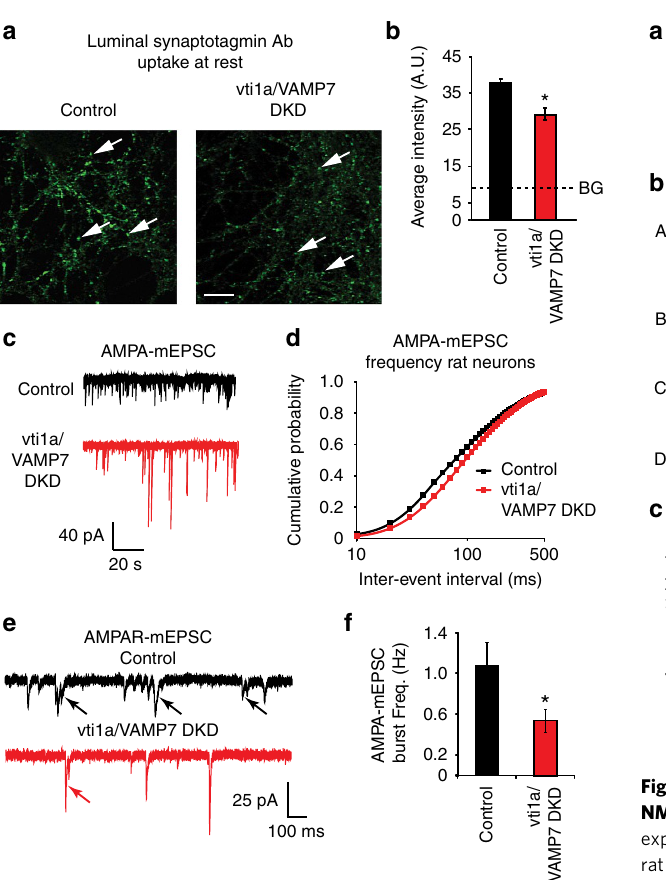
Figure 1 | Vti1a and VAMP7 loss in cultured rat hippocampal neurons decreases synaptic vesicle trafficking at rest. ( a ) Representative images of anti-luminal domain of synaptotagmin 1 antibody uptake at rest in control and vti1a/VAMP7 DKD (DKD) neurons. White arrows indicate representative areas selected for intensity analysis typical of presynaptic boutons. Scale bar, 10 m m. ( b ) Quantification of anti-luminal domain of synaptotagmin 1 antibody intensity at rest in control and vti1a/VAMP7 DKD neurons (control: n ¼ 167 puncta from 10 images from two independent cultures; vti1a/VAMP7 DKD: n ¼ 221 puncta from 11 images from two independent cultures; P ¼ 0.002). Background (BG; dashed line) fluorescence levels were obtained from similar experiments in which the primary antibody was omitted. ( c ) Representative traces of spontaneous AMPA event (AMPA-mEPSC) recordings in control and vti1a/VAMP7 DKD neurons. ( d ) Cumulative probability histograms of AMPA-mEPSC inter-event intervals (control: n ¼ 29 recordings from seven independent cultures; vti1a/VAMP7 DKD: n ¼ 31 recordings from seven independent cultures; Kolmogorov–Smirnov test; P ¼ 0.0001). ( e ) Representative traces of AMPA-mEPSC recordings containing mini-bursts (indicated by arrows) in control and vti1a/VAMP7 DKD neurons. ( f ) Average AMPA-mEPSC burst frequency was significantly decreased in vti1a/VAMP7 DKD neurons compared with control in the same recordings analysed in d ( P ¼ 0.036). of any non-use-dependent block of the receptor and should not allow substantial receptor recovery on the timescale of this experiment 25,26 . The specific, non-use-dependent NMDAR antagonist AP-5 was then added at the end of the experiment to confirm that the mEPSCs originated from NMDARs. As MK-801 only blocks open NMDARs, the extent of NMDAR block in the presence of MK-801 provides a reliable estimate of the NMDAR activity per synapse, independent of the number of synapses 17,25 . NATURE COMMUNICATIONS|8:14436|DOI: